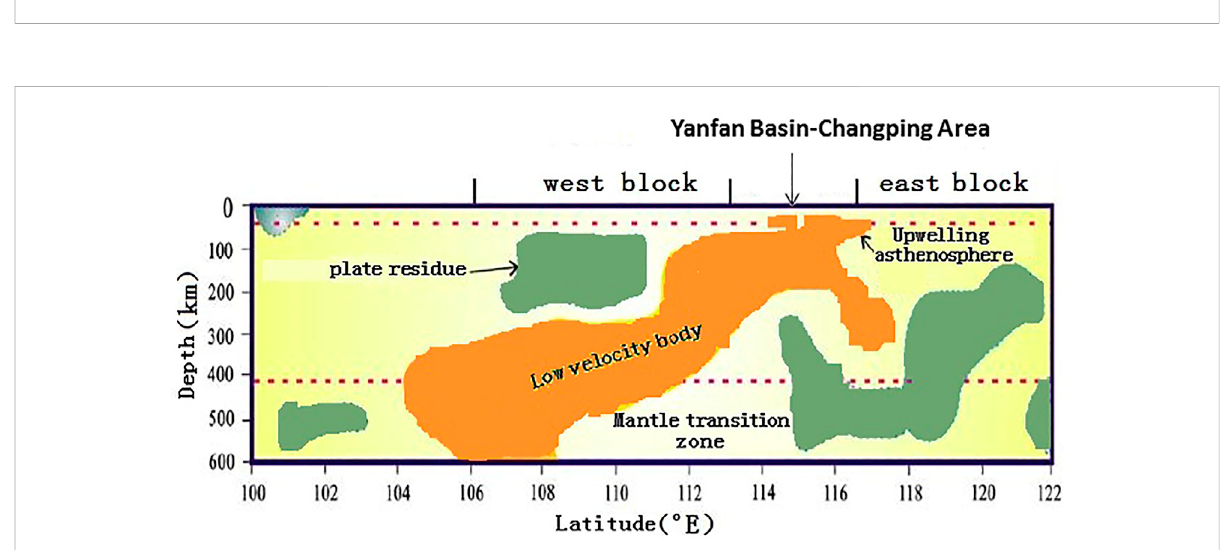
FIGURE 8 Relationship between the ratio of mantle-derived helium in geothermal wells and hot spring wells in the Zhangjiakou-Bohai Fault Zone and seismicity.